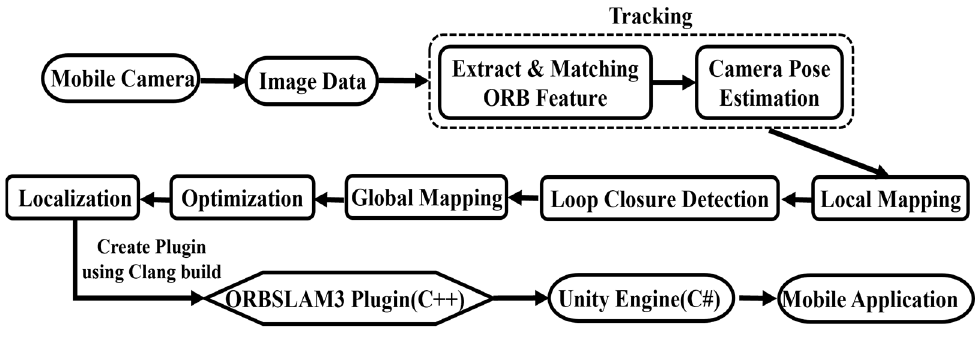
Figure 5. System